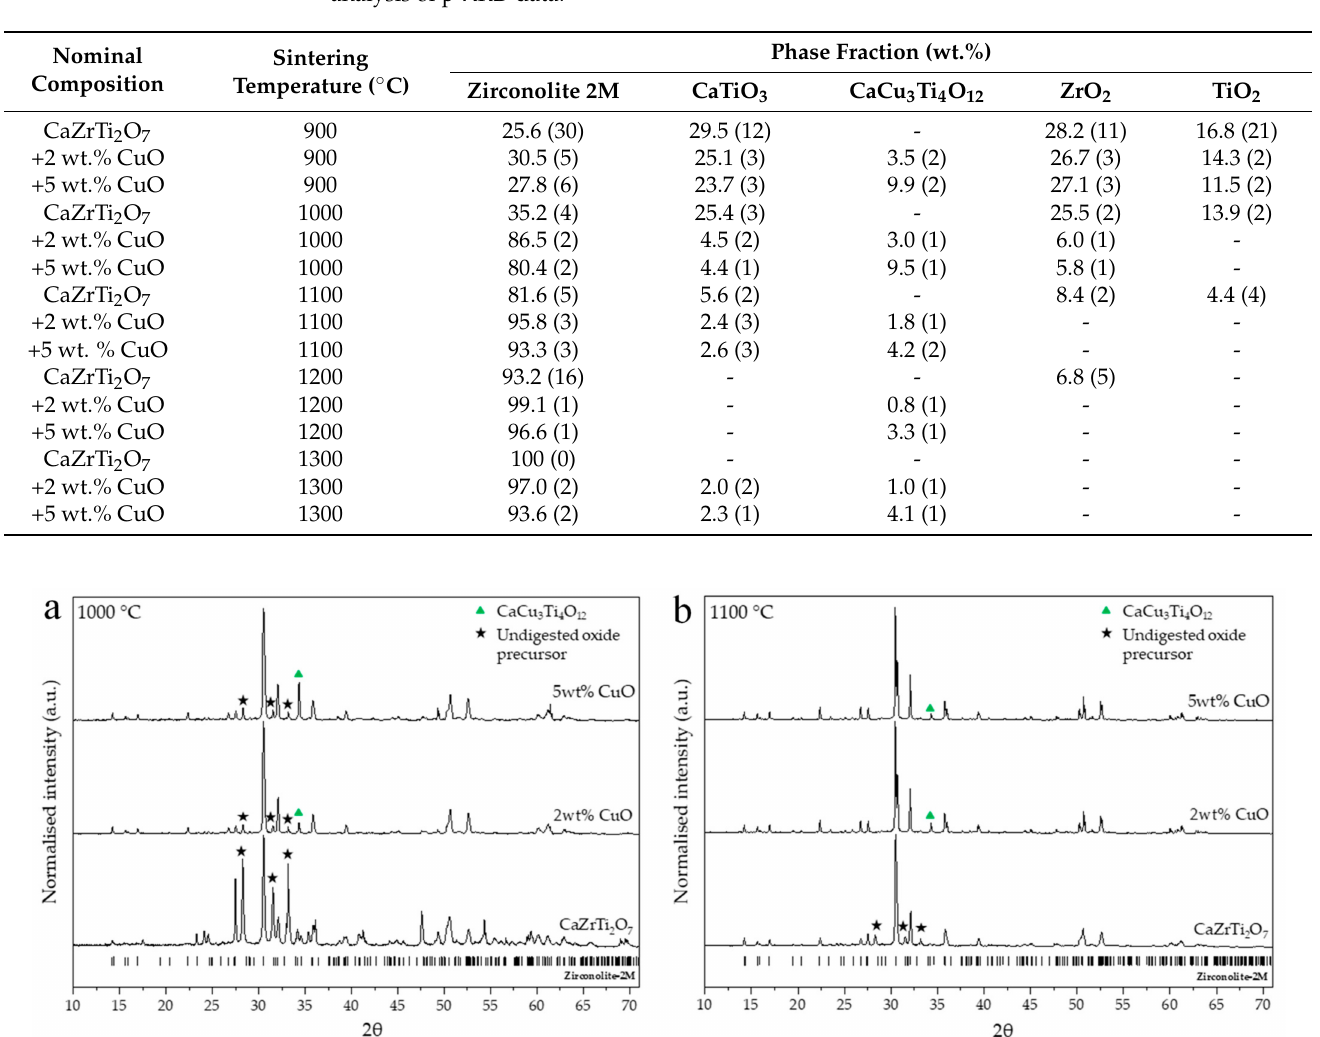
Table 1. Zirconolite phase fraction as a function of sintering temperature determined from Rietveld analysis of p-XRD data.